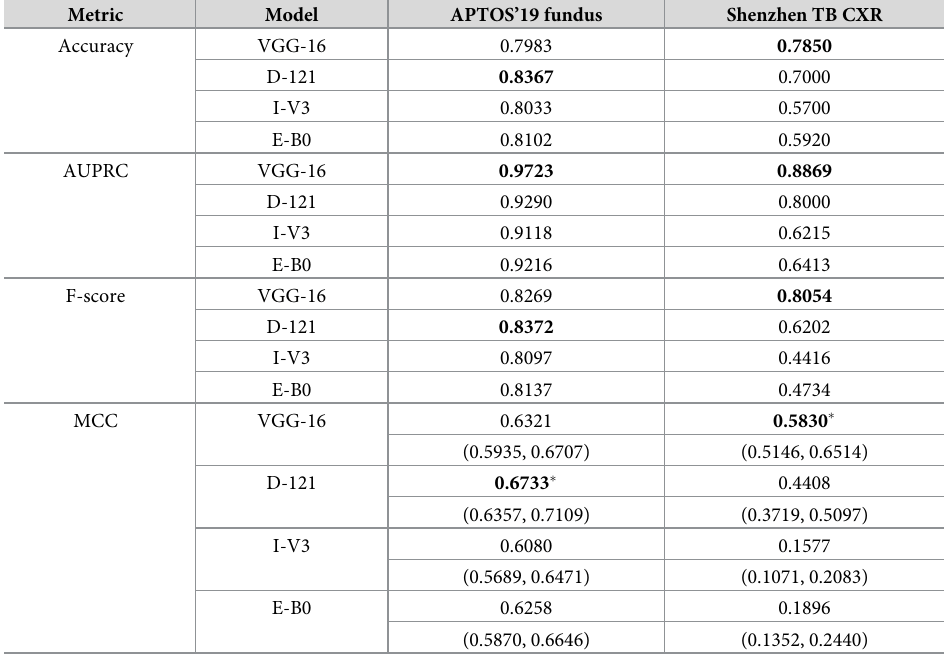
Table 2. Test performance achieved by the models that are retrained on the Set-100 dataset, individually from the APTOS’19 fundus (n = 600) and Shenzhen TB CXR (n = 200) data